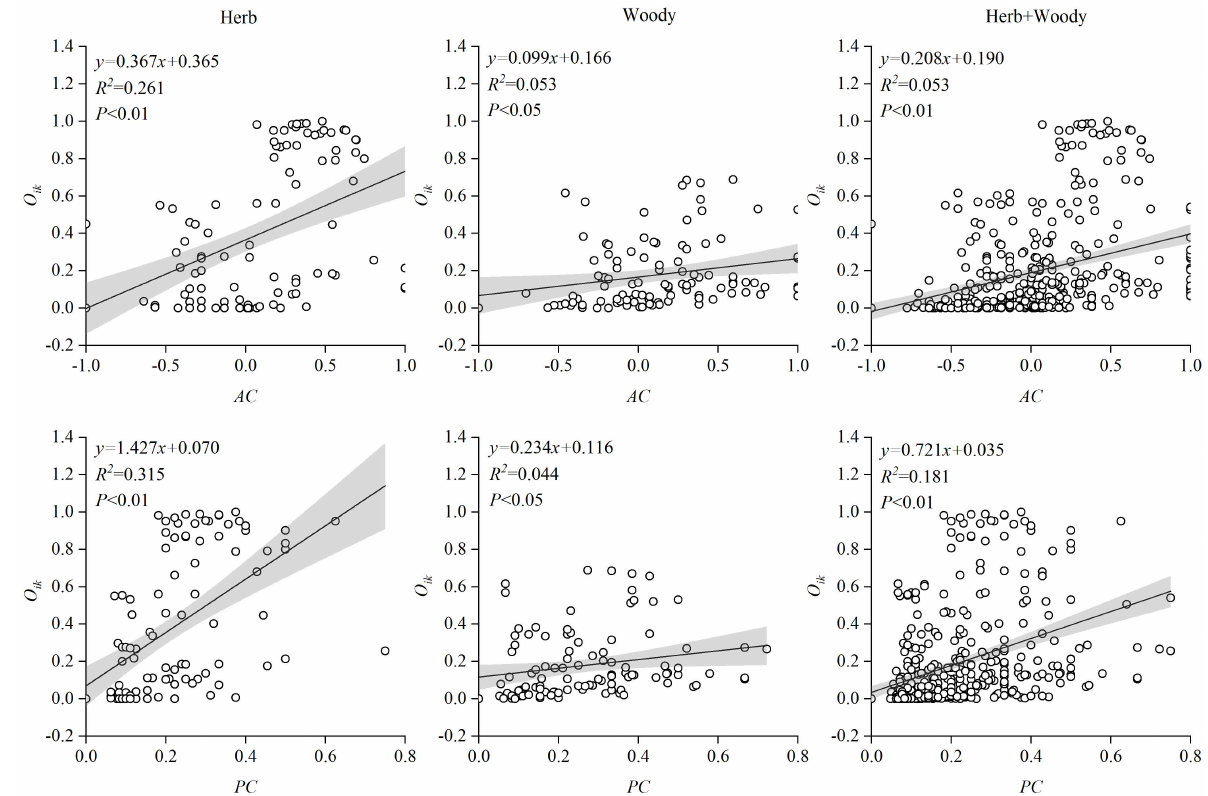
Figure 5. Regression analyses between the interspecific association coefficients ( AC and PC ) and O ik for herbs, woody plants and, herbs + woody plants. The dark color lines indicate the fits of the linear model, while the ribbon are the 95% confidence intervals of these linear models.